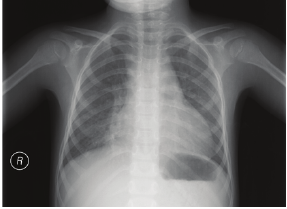
Figure 1: Chest X-ray demonstrating interstitial